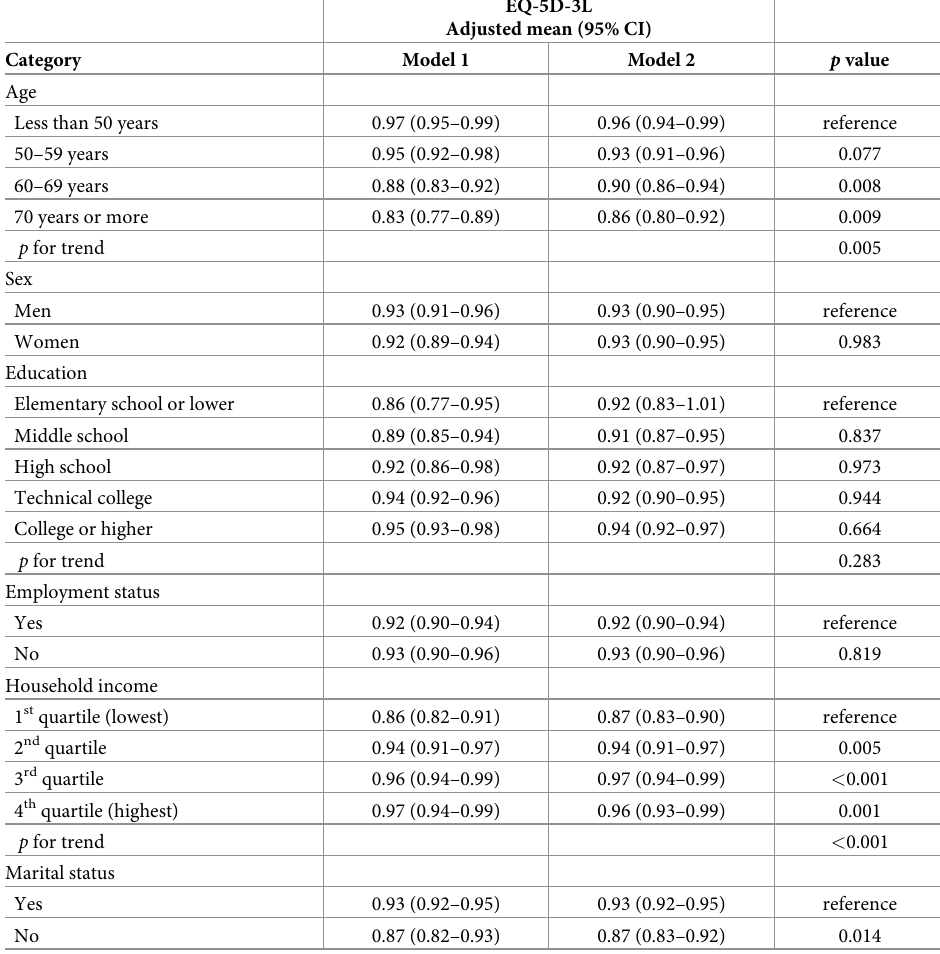
Model 1: adjusted mean values calculated using linear regression analysis after adjustments for age and sex Model 2: additionally adjusted for education, employment status, household income, martial status, glaucoma subtype, better eye cup-to-disc ratio, FDT score, and vision loss Acronyms: EQ-5D-3L, three level version of EuroQol-5D; CI, confidence